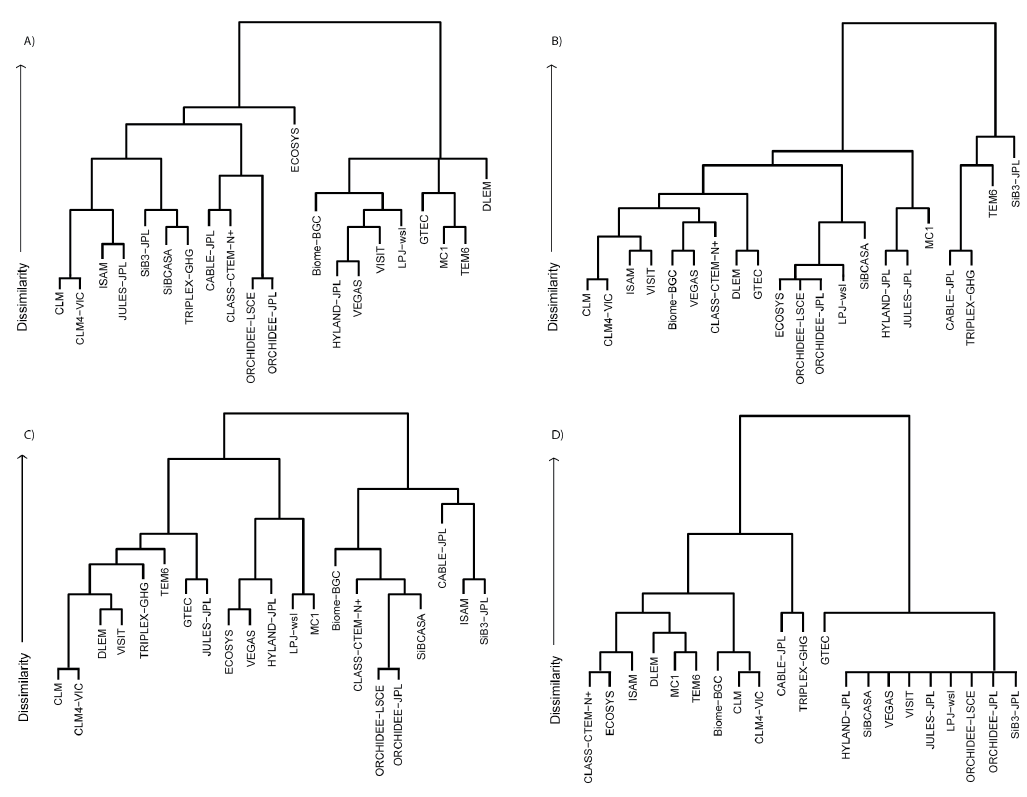
Figure 3 Fig. 3. Dendrogram showing general differences/similarities in how MsTMIP models formulate and parameterize (A) energy, (B) carbon, (C) vegetation, and (D) nitrogen process dynamics. Clusters are determined by Hamming distance. Models in the same “tree” share similar structural model characteristics. For example, models in the “tree” to the left (e.g., ISAM, CABLE-JPL, ORCHIDEE-JPL/LSCE) in (A) simulate ground heat flux and canopy heat storage, while models in the “tree” to the right (e.g., MC1, TEM6, VEGAS) do not. A majority of models separate live carbon into various pools (with exception of SiB-JPL), but they do so in various ways (e.g., left “tree” in (B) ). Refer to the Supplement for the binary data used to create this